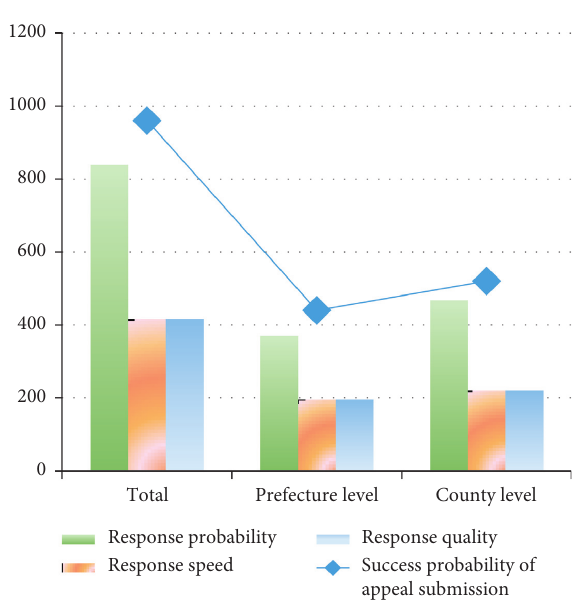
Figure 2: Distribution map of